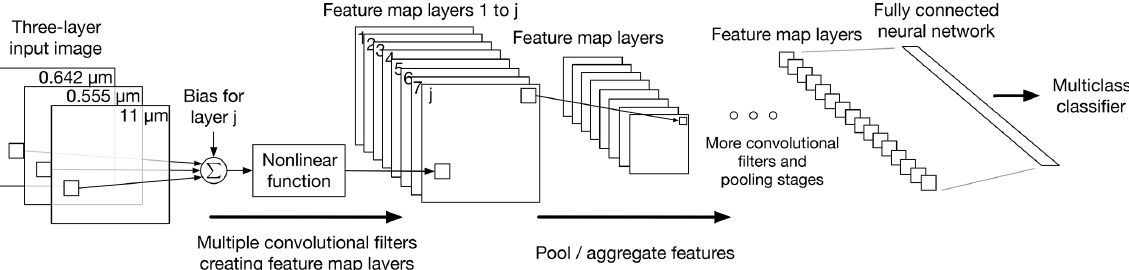
Figure 5. A convolutional neural network (CNN) extracts local spatial features from an image and combines the local spatial features to higher-order features. The higher-order features are then used to linearly separate different image types; this figure shows a simplified diagram of a CNN which gives an idea of how the local spatial features and higher-order features are created. In the first CNN layer, after the input image, the CNN has multiple multilayer convolution filters that produce feature maps: for each multilayer filter (1) the CNN convolves the filter with the input image, (2) a bias term specific to the feature map is added to each convolution sum, (3) the results are passed through a nonlinear activation function and (4) the outputs are then placed on a feature map; the nonlinear function with the convolution sums and biases gives the CNN the ability to find the nonlinear separation between different image types. The feature maps produced by the first CNN layer contain local extracted spatial features. The next CNN layer converts the local extracted spatial features into higher-order features by pooling or aggregating the features in each feature map separately using either an averaging or a max operator. The convolution and pooling– aggregation steps are repeated until a series of small feature maps are produced. Depending on the architecture of the CNN, the final layer of feature maps is then passed through a fully connected NN and then finally through a multiclass classifier.